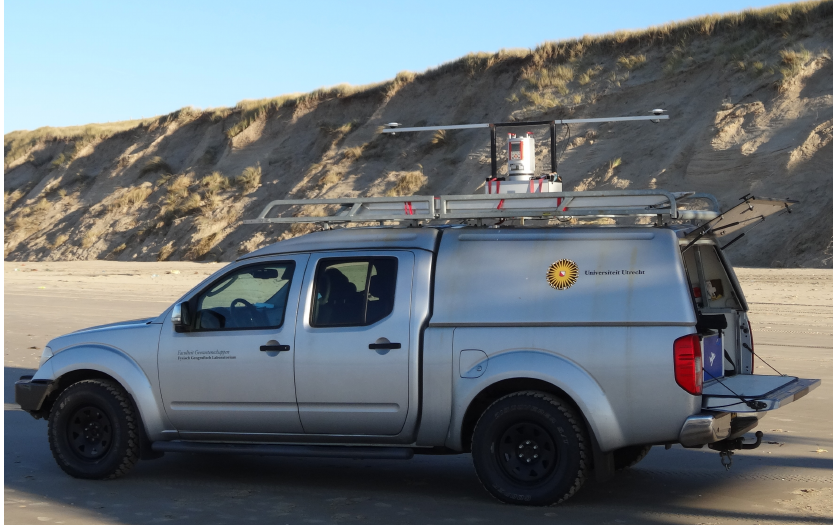
Figure 3. The car mounted MLS system with INS-GPS. The photo, taken during the Dec13 survey, also shows the eroded foredune in the